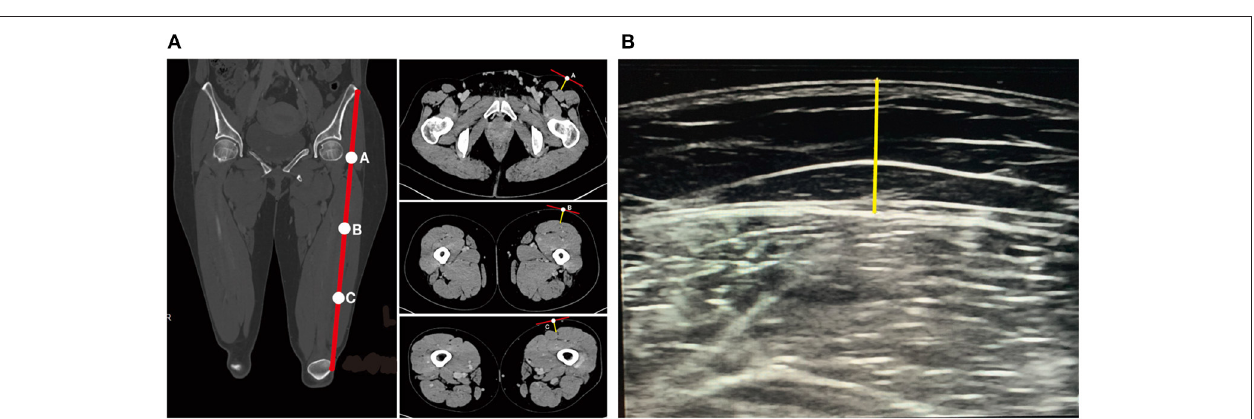
FIGURE 2 | Measurements of ALT flap thickness by CT or ultrasound. (A) Measurement of ALT flap thickness by CT. Yellow straight line indicates the thickness of ALT flap. (B) Measurement of ALT flap thickness by ultrasound. Yellow straight line indicates the thickness of ALT